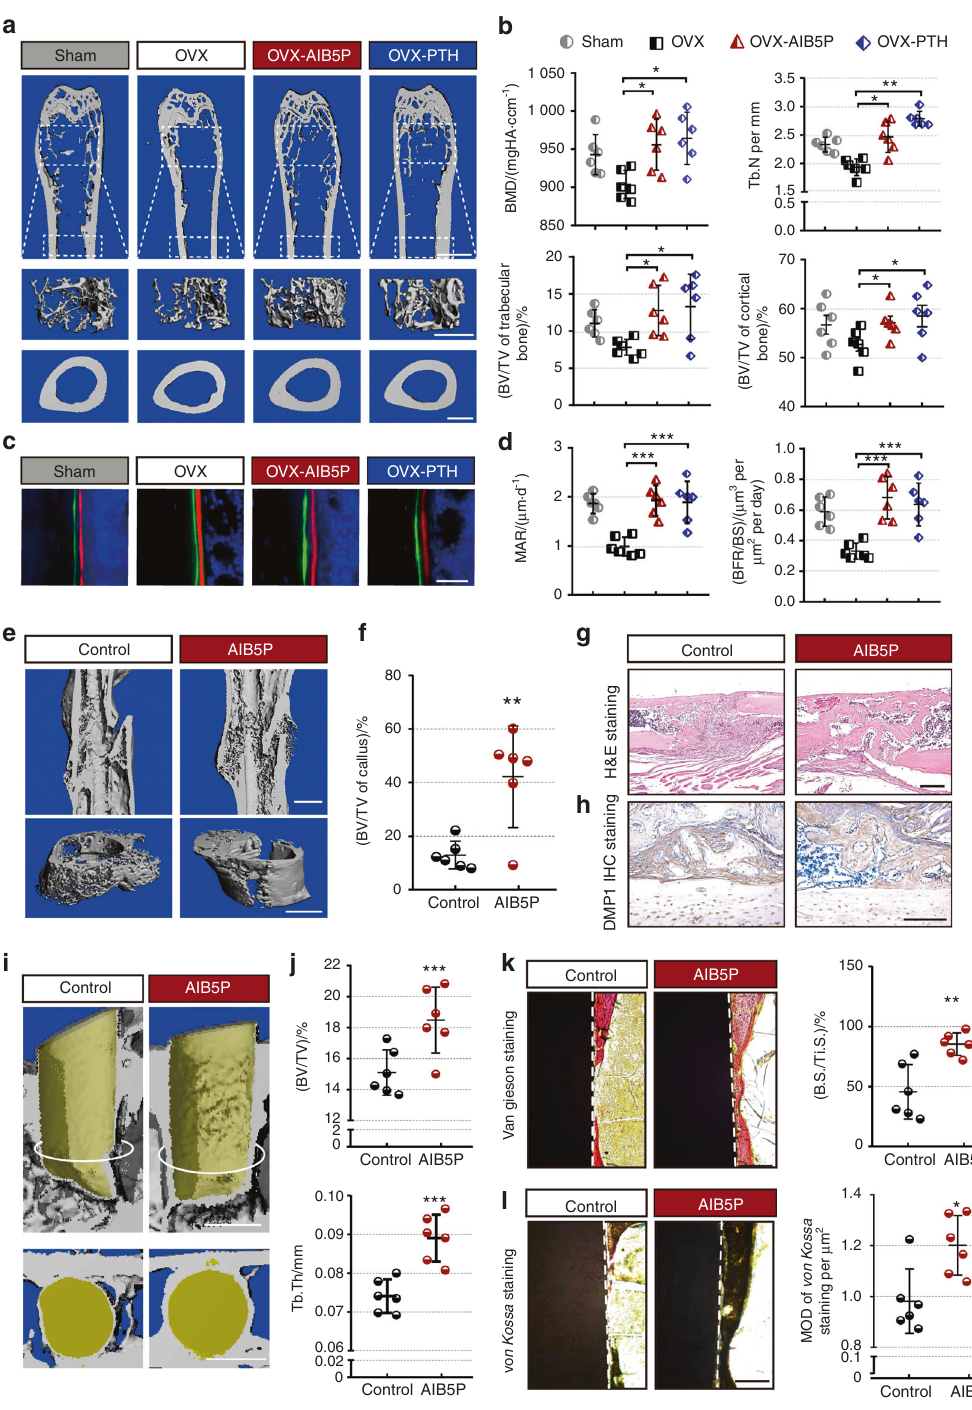
Fig. 5 Evaluation of AIB5P treatment in multiple clinical bone loss/defect models. a Representative micro-CT of femurs from the OVX mice that received treatment with AIB5P (100 μ g·kg − 1 , every 3 days, intravenous, total 1.5 months) or the known bone-formation-stimulating parathyroid hormone (PTH) (80 μ g·kg − 1 , every 3 days, subcutaneous). Upper and middle panel, bar, 1 mm. Lower panel, bar, 500 μ m. b Quanti fi cation of BMD, Tb.N, and BV/TV by micro-CT analysis. n = 6. c, d High-magni fi cation images and quanti fi cation of calcein and xylenol orange double labeling of femur sections. Samples from six mice were used. e Upper, representative micro-CT images of femurs. Lower, representative micro-CT r statistics. Bar, 50 images of callus. Bar, 1 mm. f Quanti fi cation of BV/TV in callus. n = 6. g, h Representative H&E staining and anti-DMP1 IHC staining images of fractured femur sections. Bar, 200 μ m. i Representative micro-CT images of vertical sections of implants (osteointegration model) treated with AIB5P (every 3 days, 100 μ g·kg − 1 , intravenous, 3 weeks) or vehicle. The white circle line indicates the horizonal section position. Lower, cross-sectional view of bone formation surrounding the implant. Bar, 1 mm. j Quanti fi cation of new bone thickness on the implant surface. n = 6. k Van Gieson staining and bone quanti fi cation of the midshaft surface of implants. Bone surface per titanium implant surface (B.S./Ti.S.). Bar, 100 μ m. n = 6. l von Kossa staining images and relative quanti fi cation of new bone formation in the implant model. Bar, 100 μ m. n =